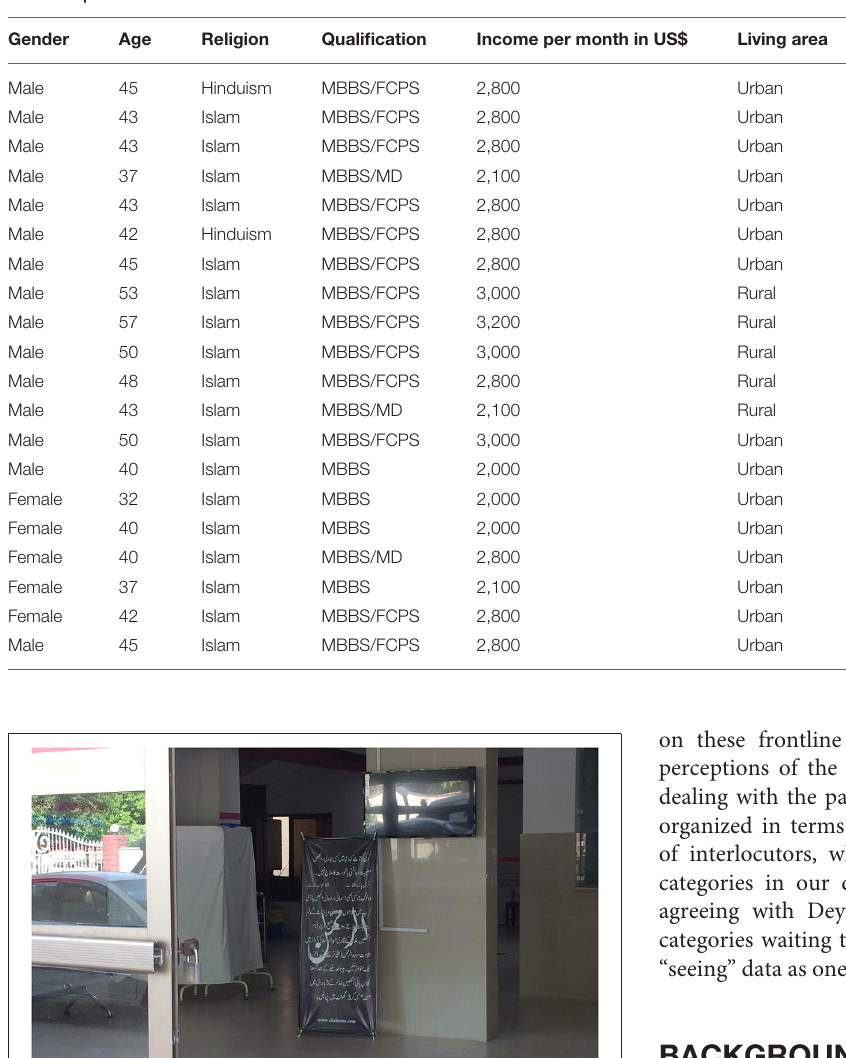
TABLE 1 | Characteristics of interlocutors.